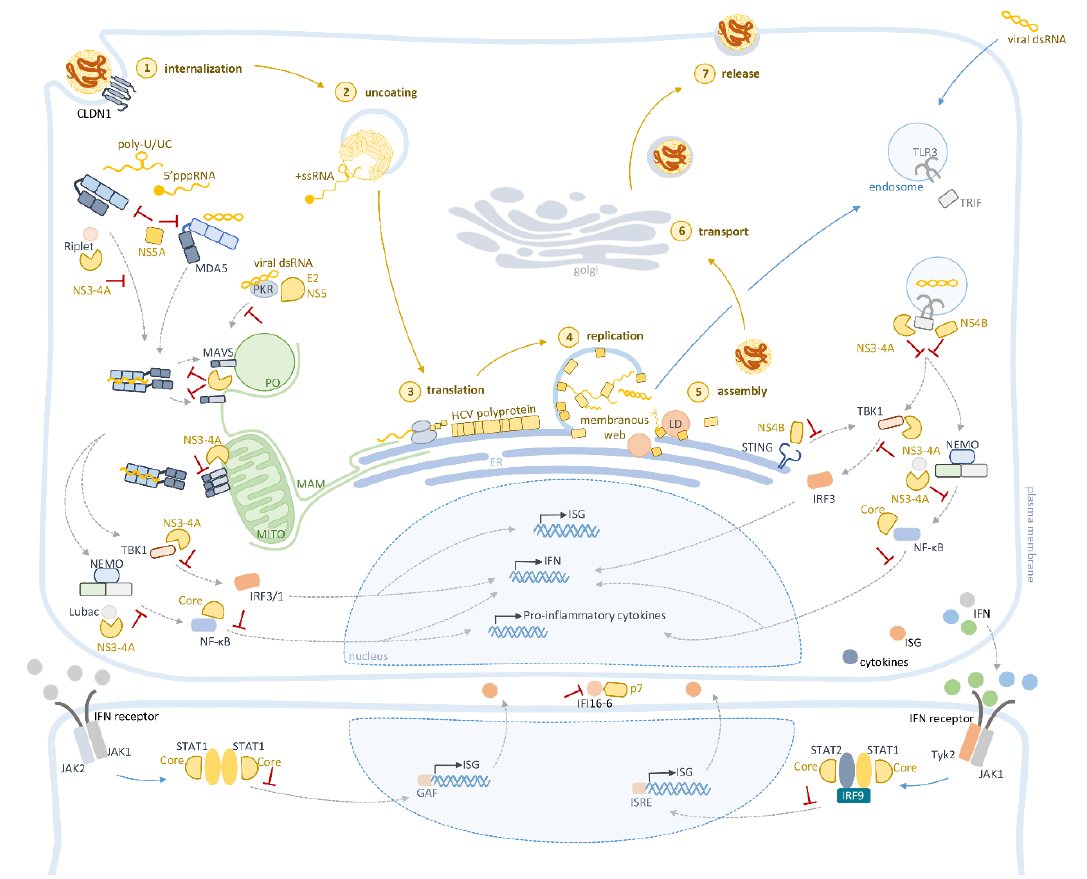
Figure 3. Evasion of the intracellular innate immunity response by hepatitis C virus (HCV) proteins. HCV NS3-4A, E2, NS5A, NS4B, p7, and core target several steps of the pattern recognition receptors (PRRs) signaling involved in HCV sensing, downregulating the expression of interferons (IFNs), proinflammatory cytokines and IFN-stimulated genes (ISGs), and consequently inhibiting the intracellular antiviral response.